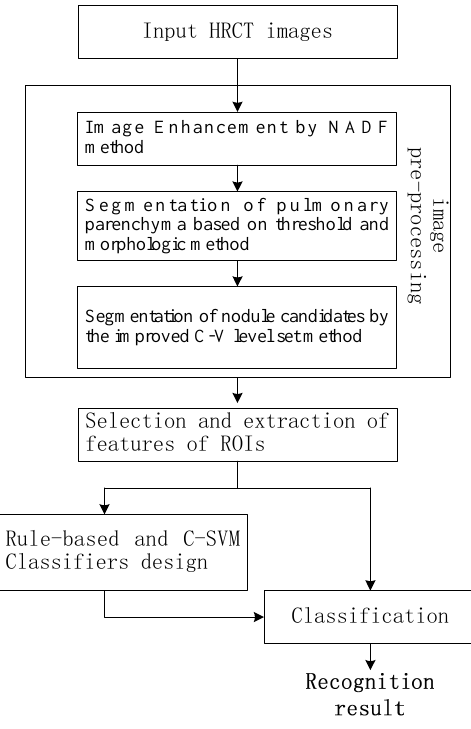
Fig. 1. Flowchart of the proposed recognition method for lung nodules